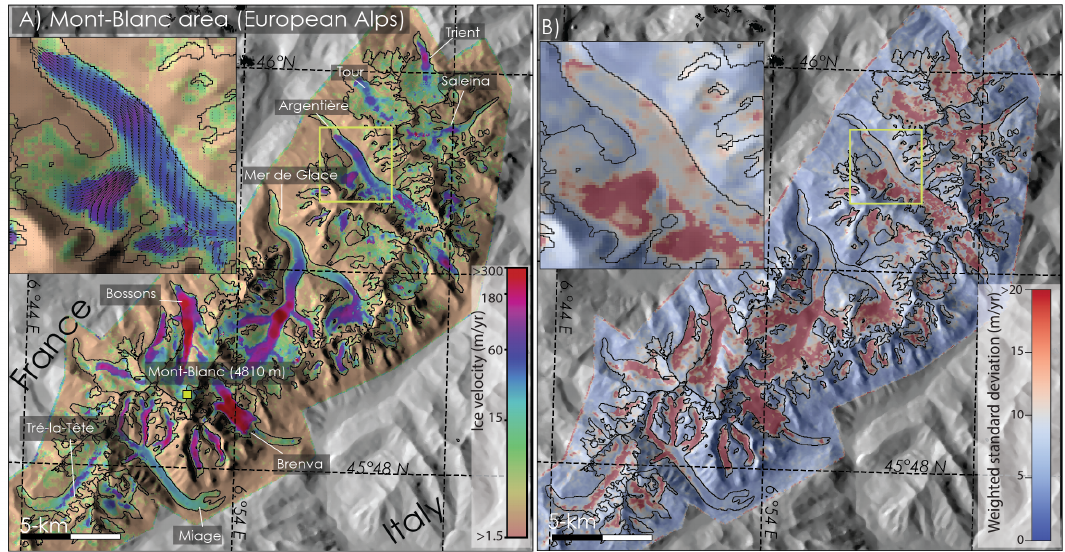
Figure 2. ( A ) Glacier surface velocity mosaic of the Mont-Blanc massif (European Alps) in meters per year averaged over 2017–2018 from Sentinel-2 images. Colorbar is coded on a logarithmic scale and overlaid on a shaded relief version of the SRTM DEM; ( B ) Weighted standard deviation color coded from white (low variance) to dark red (high variance). Insets show a zoom on the tongue of Argentière glacier for each